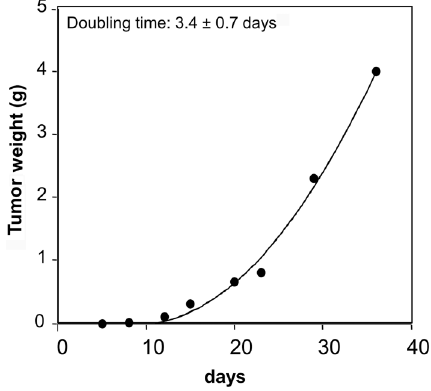
Figure 7. SK-N-SH cells (40 (cid:1) 10 6 cells) were inoculated by sc injection in athymic nude mice and left to grow for 35 days. The results are representative of 2 experiments done in triplicate.